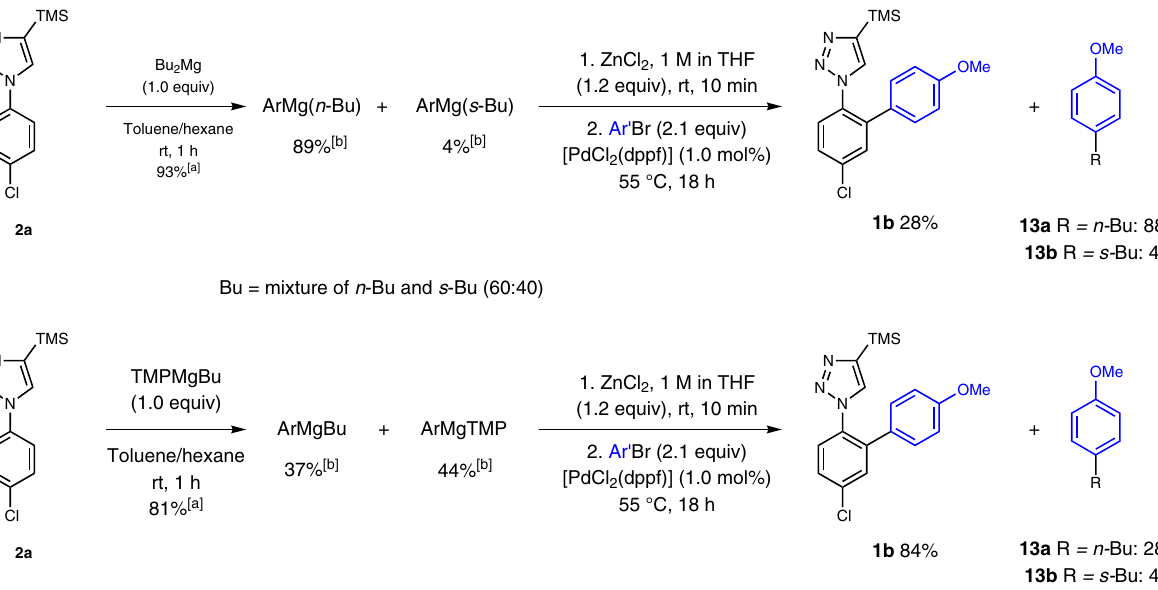
Fig. 6 Mechanistic probes. [a] Metalation yields were determined by 1 H-NMR analysis of D 2 O-quenched reaction aliquots. [b] Yields were determined by GC analysis of iodolyzed aliquots using undecane as an internal standard. Ar = 5-Cl-2-(4-TMS-1 H -1,2,3-triazol-1-yl)-C 6 H 3 . Ar ′ = 4-MeO-C 6 H 4